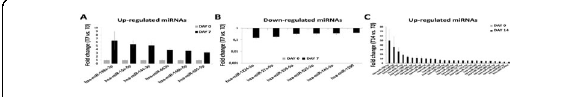
Fig. 1 (abstract 000385). See text for